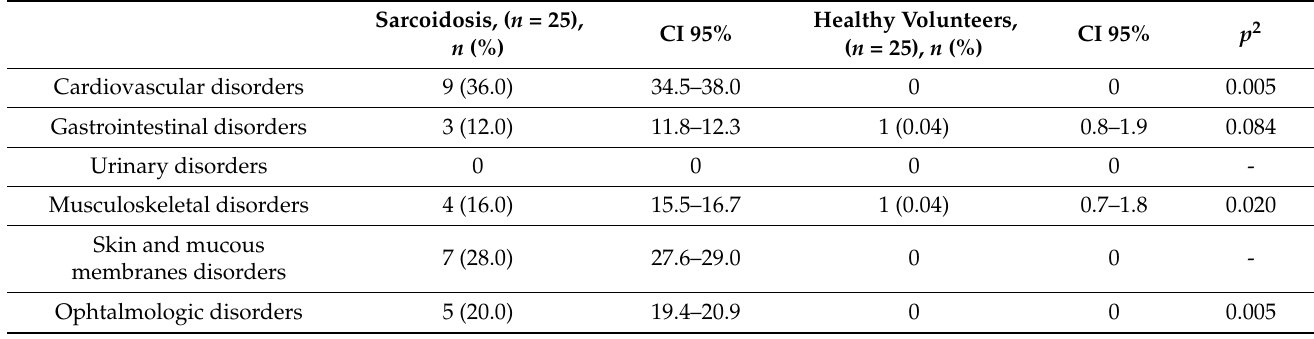
Table 2. Clinical symptoms of small fiber neuropathy in patients with pulmonary sarcoidosis and healthy volunteers.